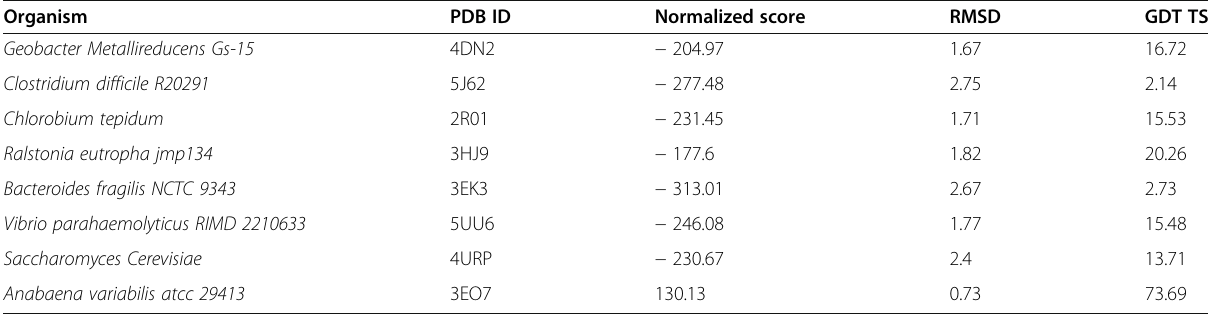
Table 1 Structural alignment of the Arabidopsis O23673 protein (Locus At1g02020) with nitroreductases with defined structures from different species